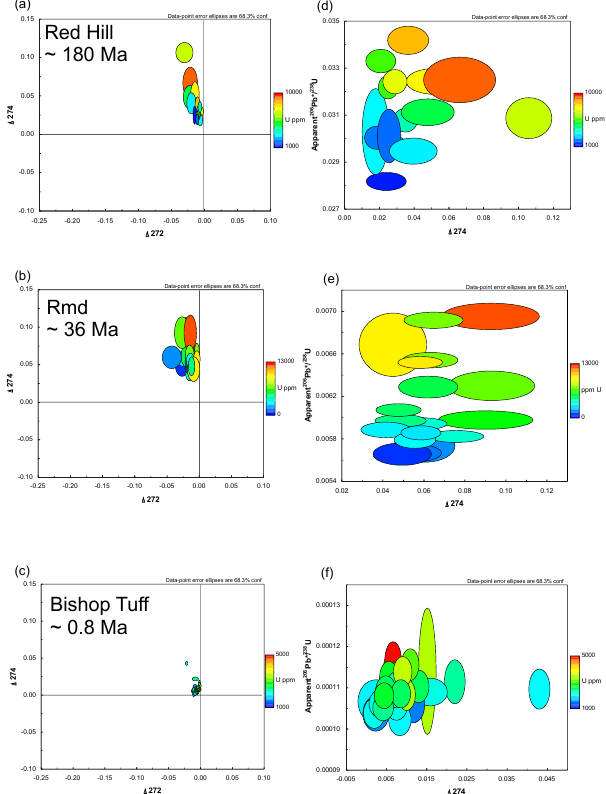
Figure 3. (a,b,c) (cid:49) 272 vs. (cid:49) 274 plots for analyses of high- uranium zircons of three different ages. (d, e, f) Apparent 206 Pb / 238 U ratio vs. (cid:49) 274, colour coded for U content, for high- uranium zircons of three different